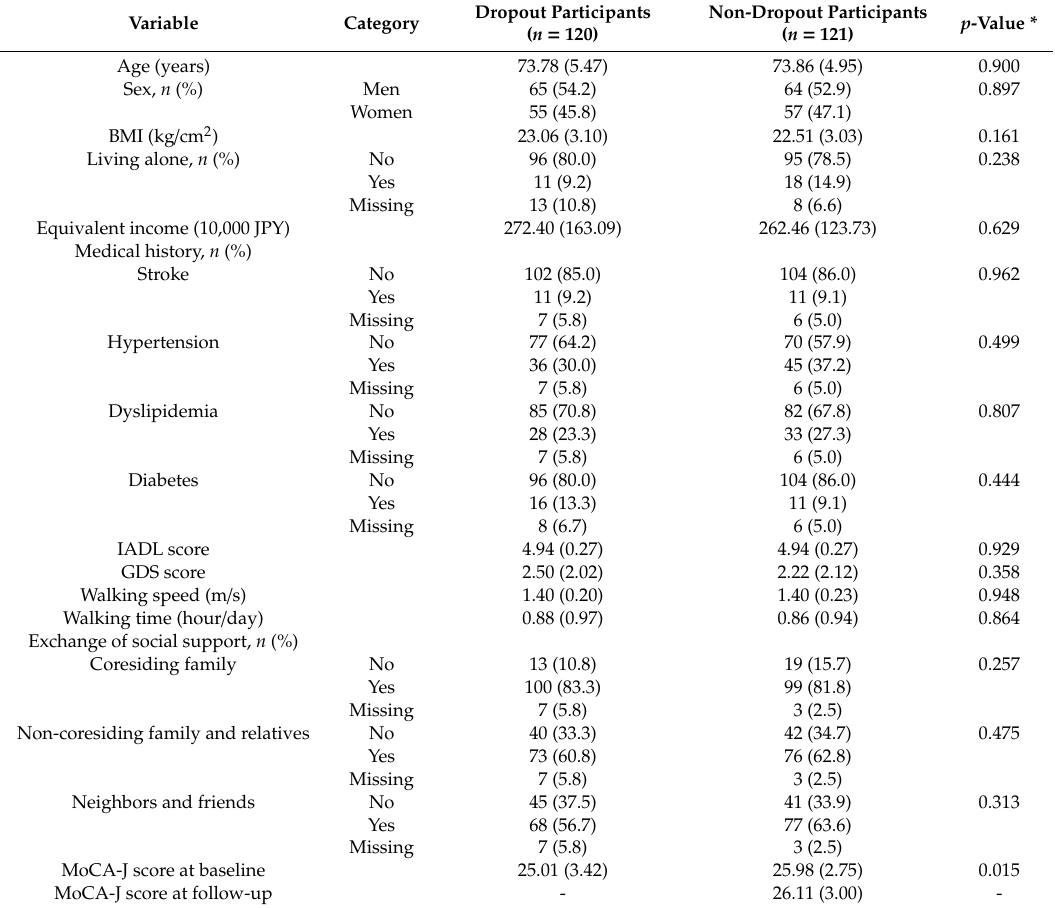
Table 1. Participant